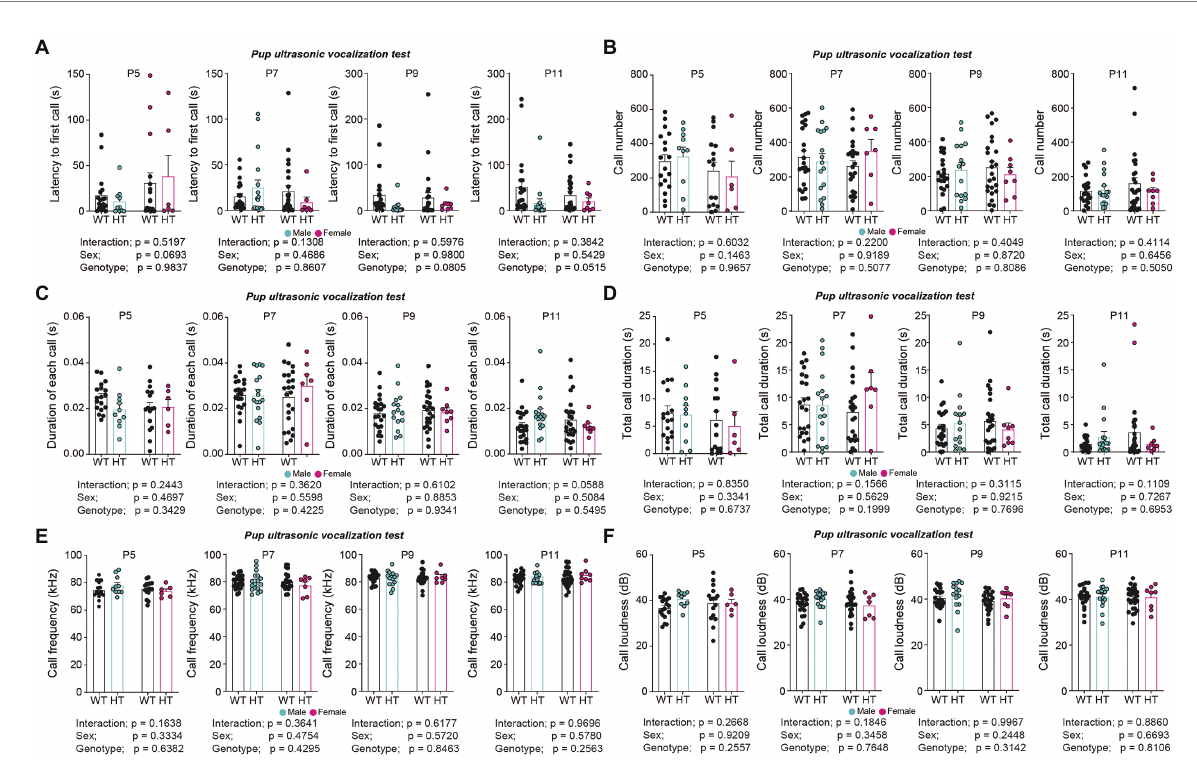
FIGURE 2 Largely normal USVs in pups separated from their mothers in Chd8 +/S62X male and female mice. (A) Latency to first call in WT and Chd8 +/S62X pups at P5, P7, P9, and P11. WT, wild-type; HT, heterozygote ( Chd8 +/S62X ). ( n = 21 mice [male-WT], 17 [male-HT/heterozygote], 26 [female-WT], and 8 [female-HT], ns, not significant, two-way ANOVA). (B) Number of USV calls in WT and Chd8 +/S62X pups. ( n = 21 mice [male-WT], 17 [male-HT/ heterozygote], 26 [female-WT], and 8 [female-HT], ns, not significant, two-way ANOVA). (C) Duration of each call in WT and Chd8 +/S62X pups. ( n = 21 mice [male-WT], 17 [male-HT/heterozygote], 26 [female-WT], and 8 [female-HT], ns, not significant, two-way ANOVA). (D) Total duration of USV calls in WT and Chd8 +/S62X pups. ( n = 21 mice [male-WT], 17 [male-HT/heterozygote], 26 [female-WT], and 8 [female-HT], ns, not significant, two-way ANOVA). (E) USV call frequency in WT and Chd8 +/S62X pups. ( n = 21 mice [male-WT], 17 [male-HT/heterozygote], 26 [female-WT], and 8 [female-HT], ns, not significant, two-way ANOVA). (F) USV call amplitude in WT and Chd8 +/S62X pups. ( n = 21 mice [male-WT], 17 [male-HT/ heterozygote], 26 [female-WT], and 8 [female-HT], ns, not significant, two-way